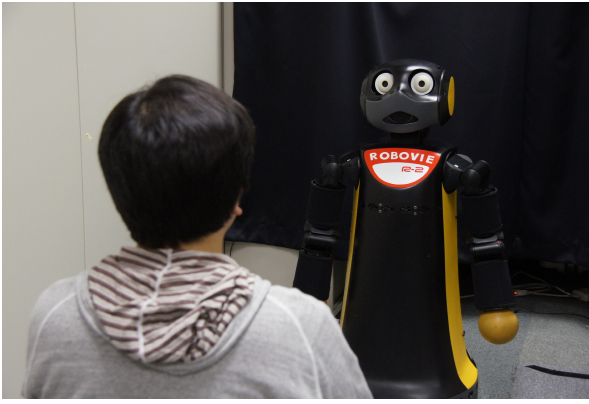
Figure 3: A participant sitting 1.5m in front of Robovie R2.